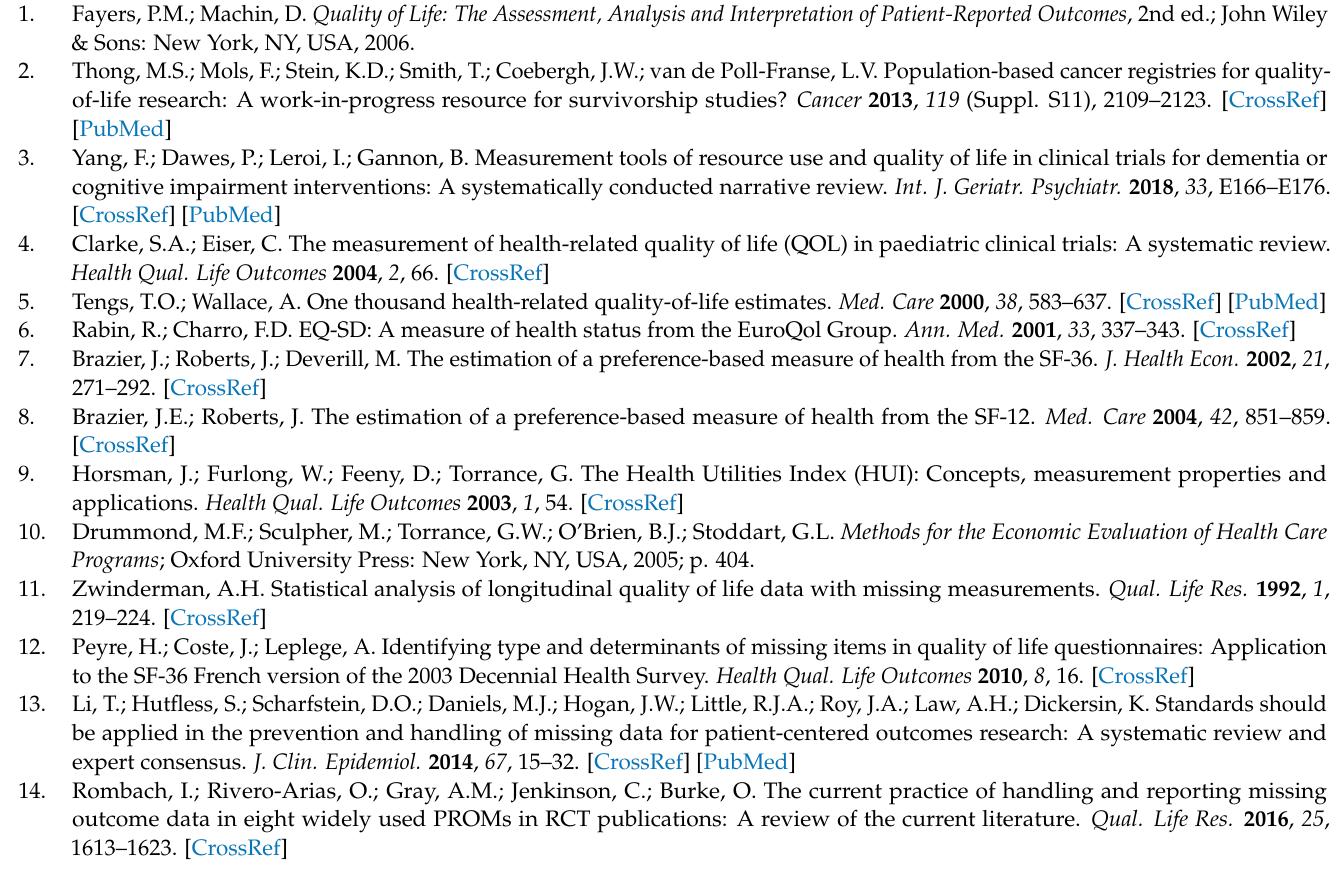
Figure S6: Simulated missingness of the selected 11 SF-36 items in the five-year follow-up for the analytical dataset (red cells indicating